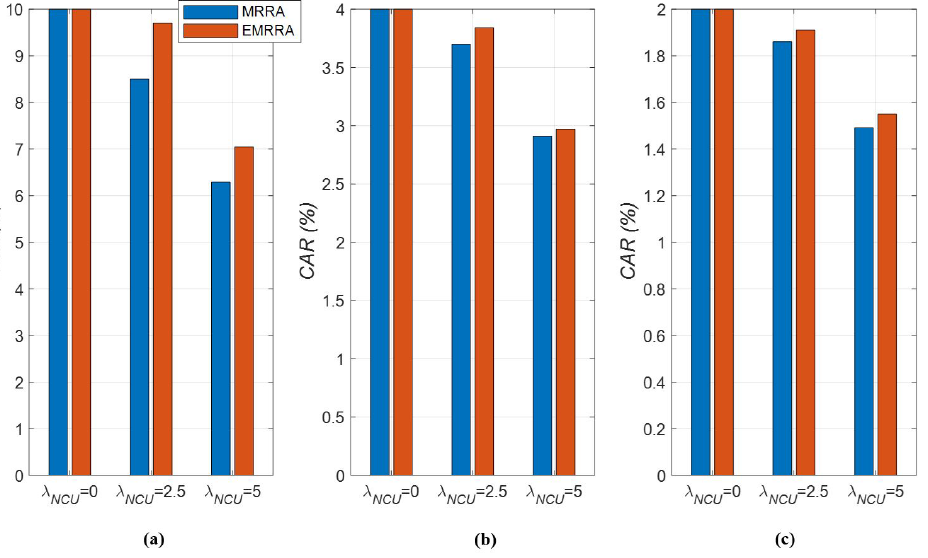
Figure 10. The channel allocation rates of EMRRA and MRRA with respect to λ NCU , K , and N CU : ( a ) N CU = 10, K = 50; ( b ) N CU = 25, K = 50; ( c ) N CU = 50, K = 50.